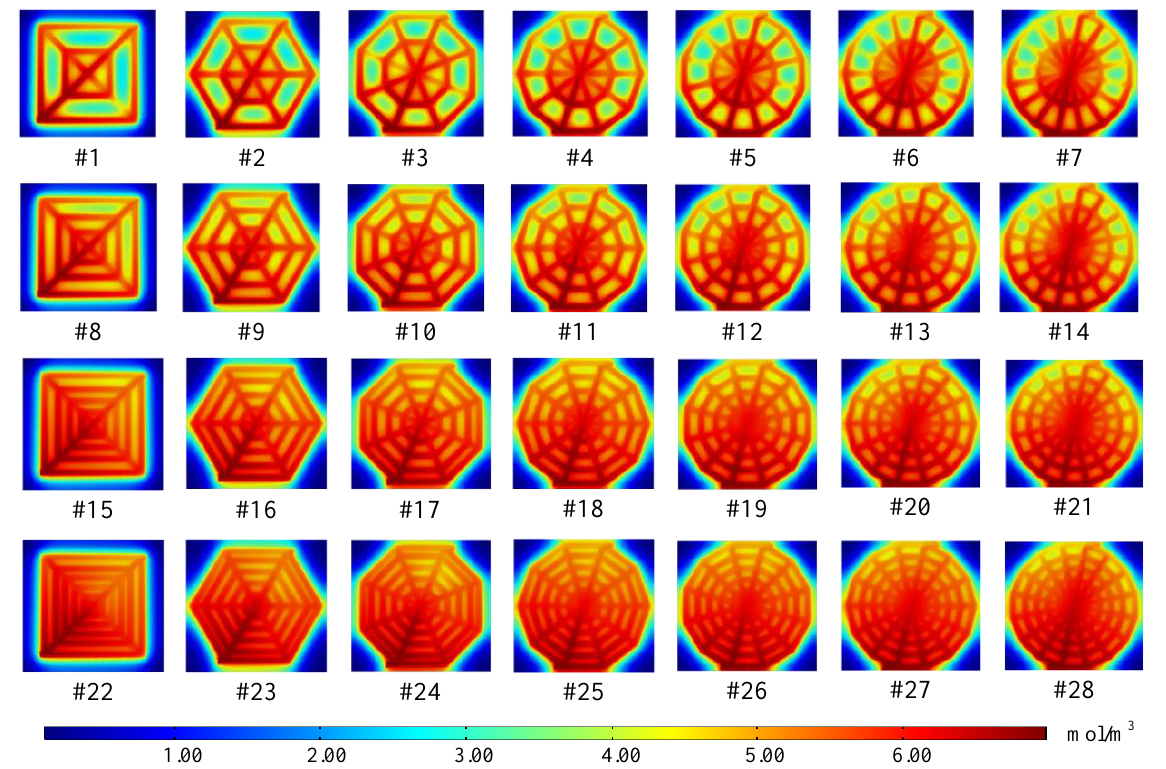
Figure 5. The oxygen distribution of different schemes at the interface of the cathode GDL and CL.